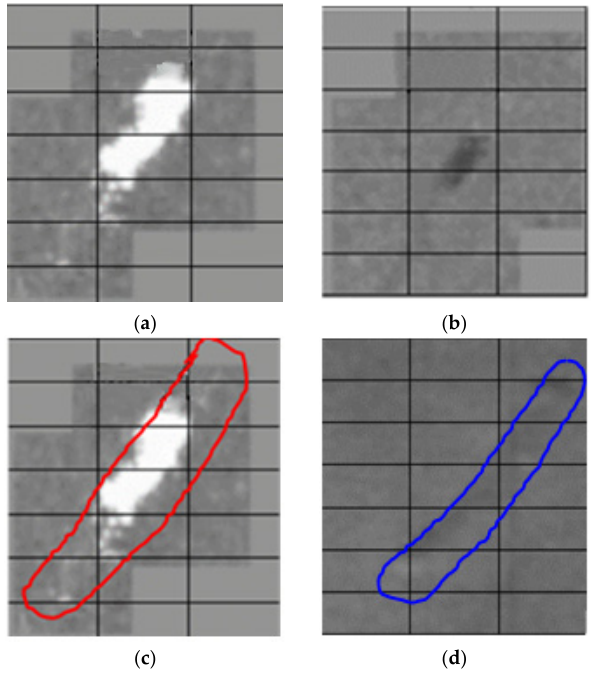
Figure 15. Comparison of the defect in the hot-rolling mill and the pickling line (processed in Ametek): ( a ) Hot-rolling mill check; ( b ) Pickling line check; ( c ) Evaluation of defect’s position with respect to the strip’s axis in the hot-rolling mill; ( d ) Evaluation of defect’s orientation with respect to the strip’s axis in the pickling line. checked against the expected position of the defect on the strip in the pickling process. A